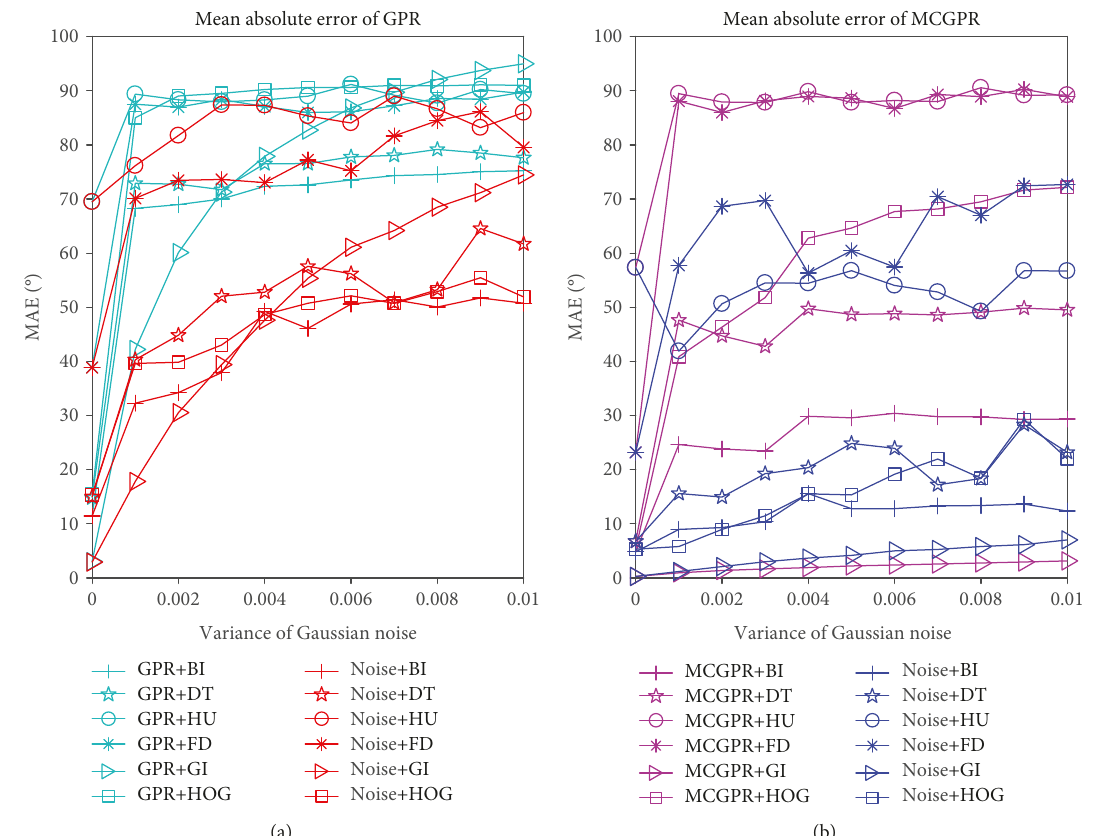
Figure 5: Noise robustness results of GPR and MCGPR for pose estimation